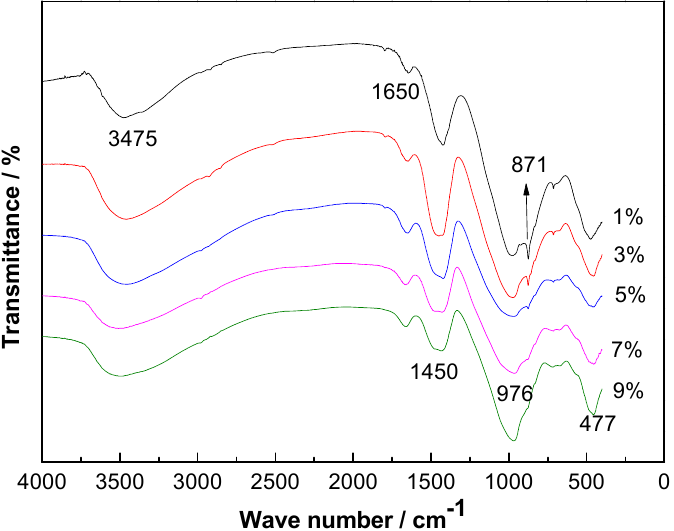
Figure 11. FT-IR spectra of alkali-activated CNS materials after hydration with different sodium Figure 11. FT ‐ IR spectra of alkali ‐ activated CNS materials after hydration with different sodium silicate silicate contents.